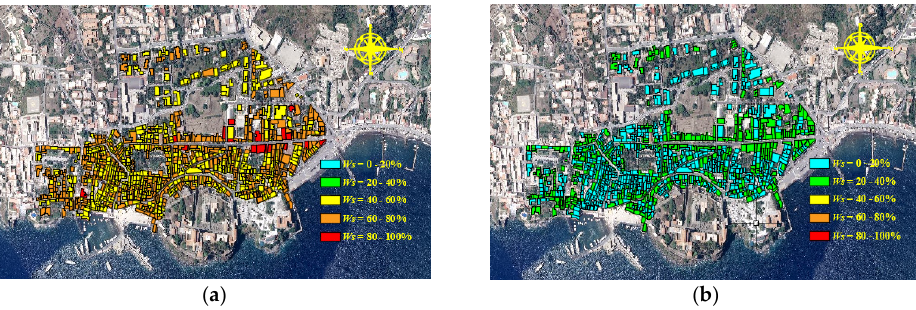
Figure 7. Obtained values of WS for the large-scale installation of RWH systems in the area under study ( N = 25, f = 0.5, and r = 3%): ( a ) average in the year; ( b ) wet season; ( c ) dry season.